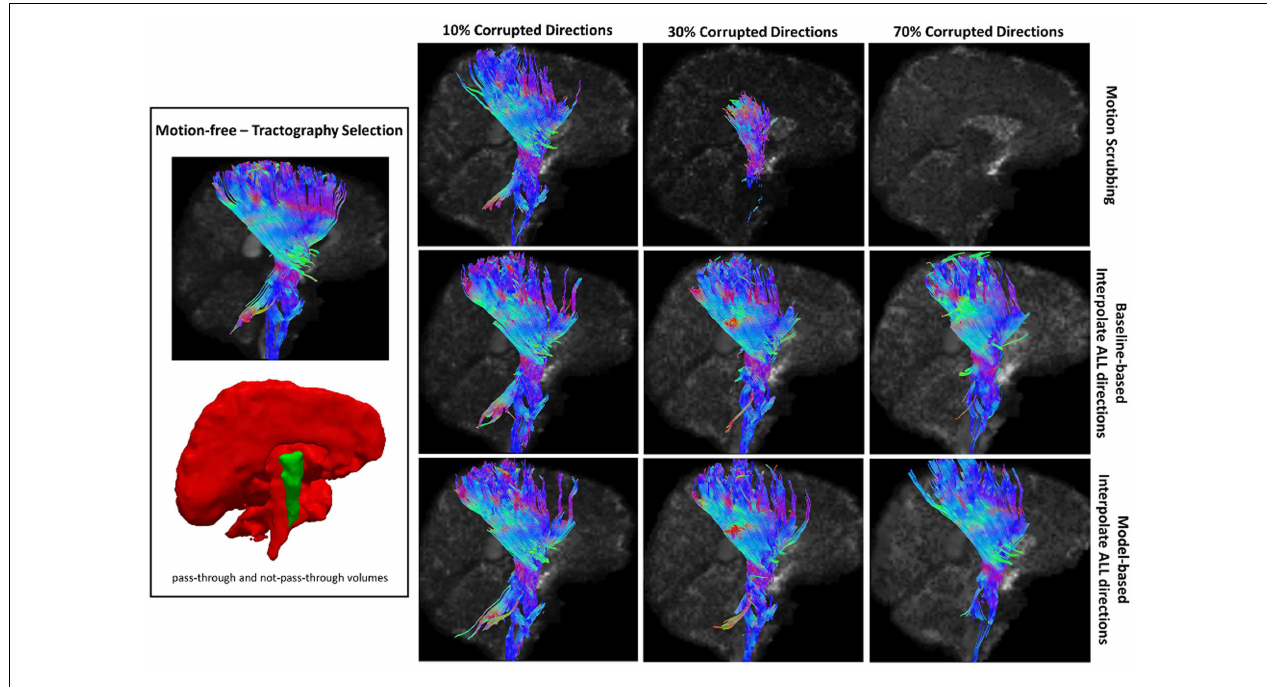
outlier-based (i.e., motion scrubbing) and registration-based (using baseline and model-based reference volumes). Note that motion scrubbing cannot recover long tracts such as CST beyond 10% motion corruption.